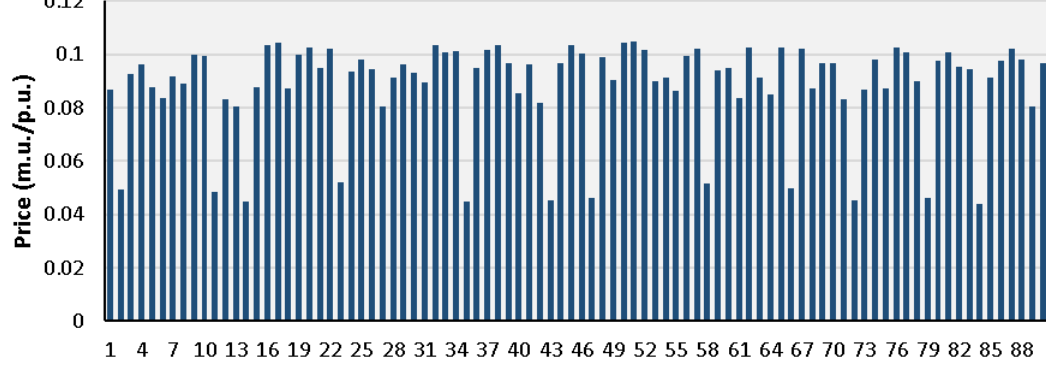
Figure 2. Curtailment prices for consumers.